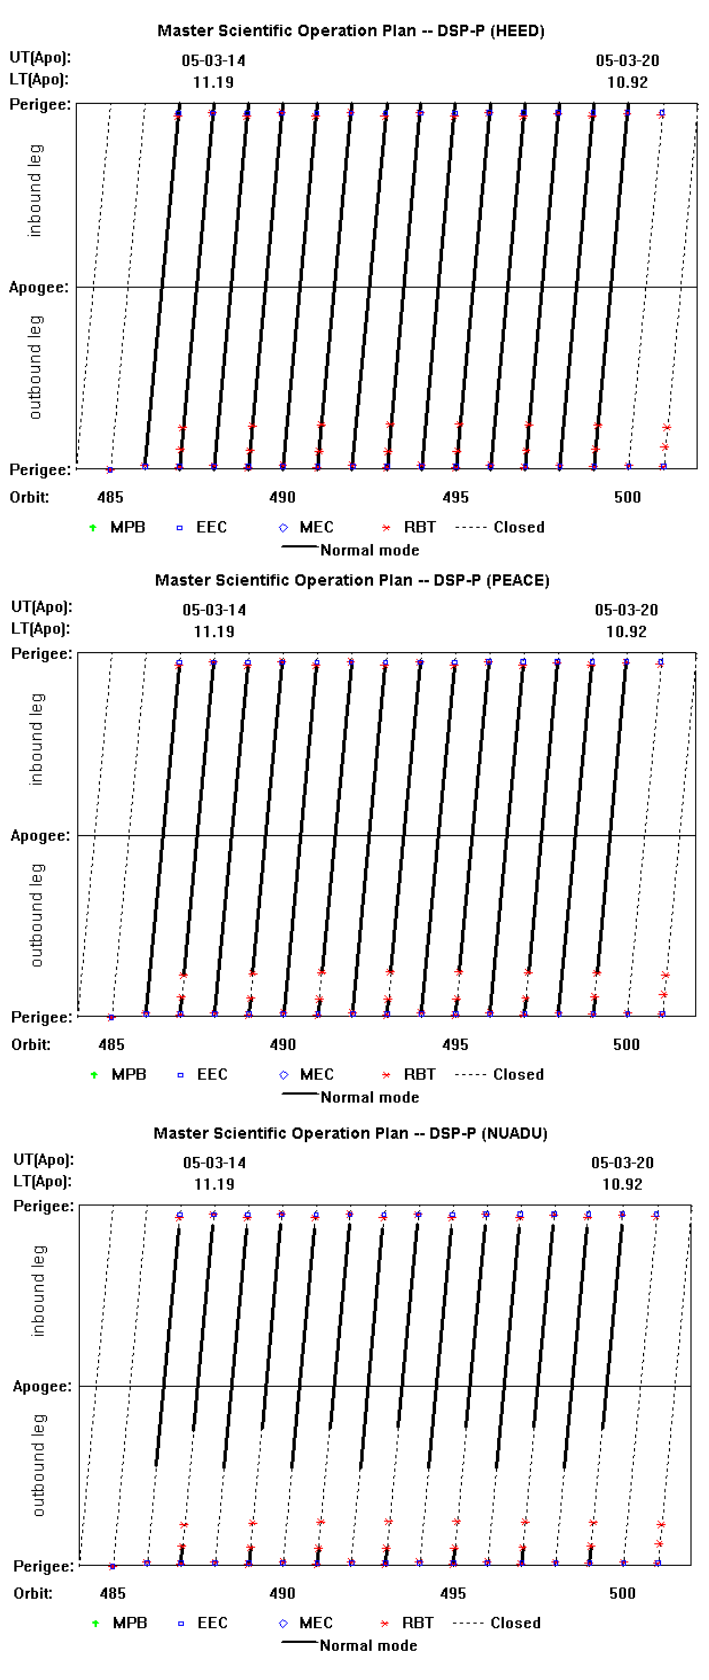
Fig. 10. The Bryant plots of the op- eration plans of HEED (upper panel), PEACE (mid panel) and NUADU (lower panel) of TC-2 during the plan- ning period 65 (orbit 486–499) on 14–21 March 2005. The operations plan of FGM/HEPD/HID/LEID/LEFW is the same as that of HEED. The mean- ings of the symbols in the plots are the same as that of Fig.